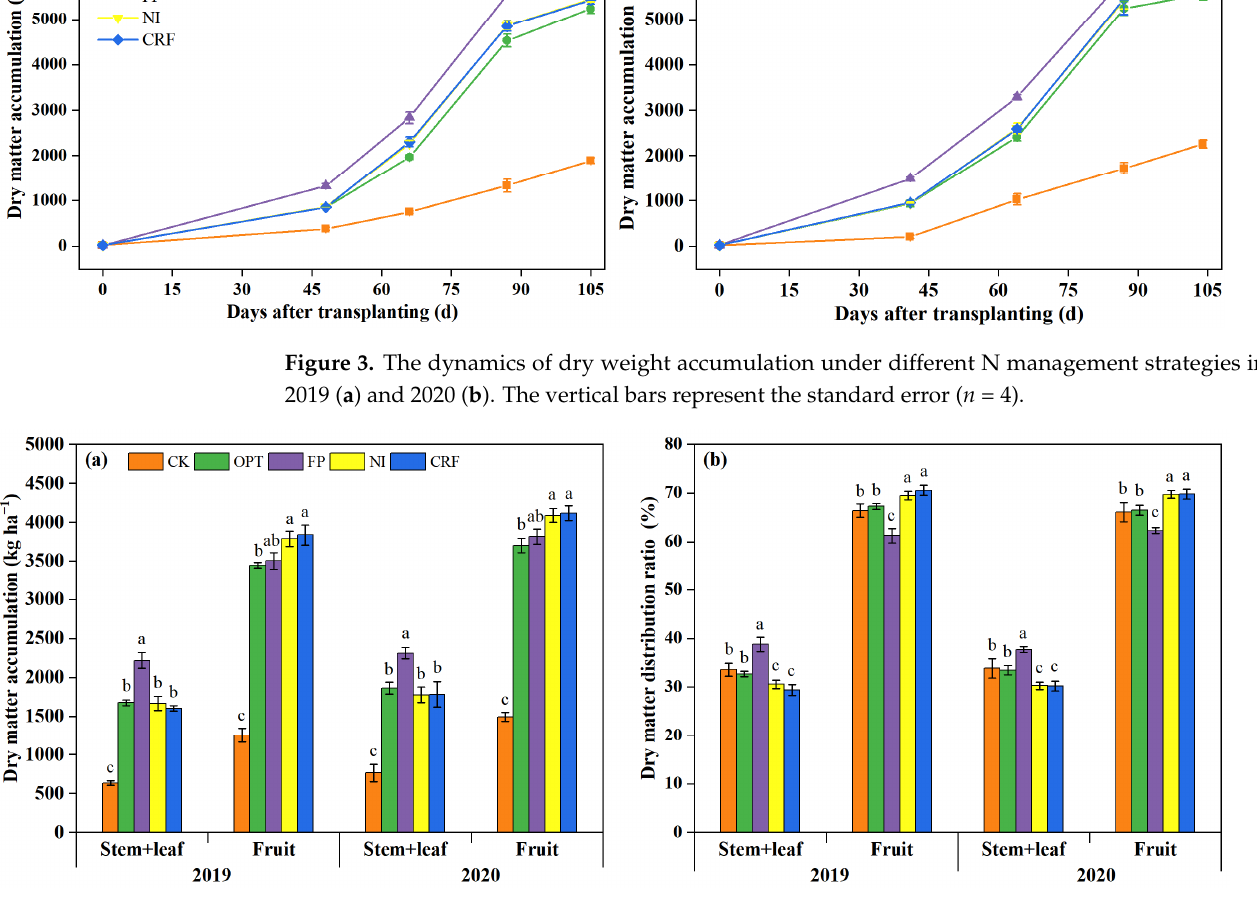
Figure 4. Amount ( a ) and proportion ( b ) of dry matter allocated in vegetative organs (stem + leaf) and fruit in the harvesting periods in 2019 and 2020. Different lowercase letters indicate statistical significance at the p = 0.05 level. The vertical bars represent the standard error ( n = 4).